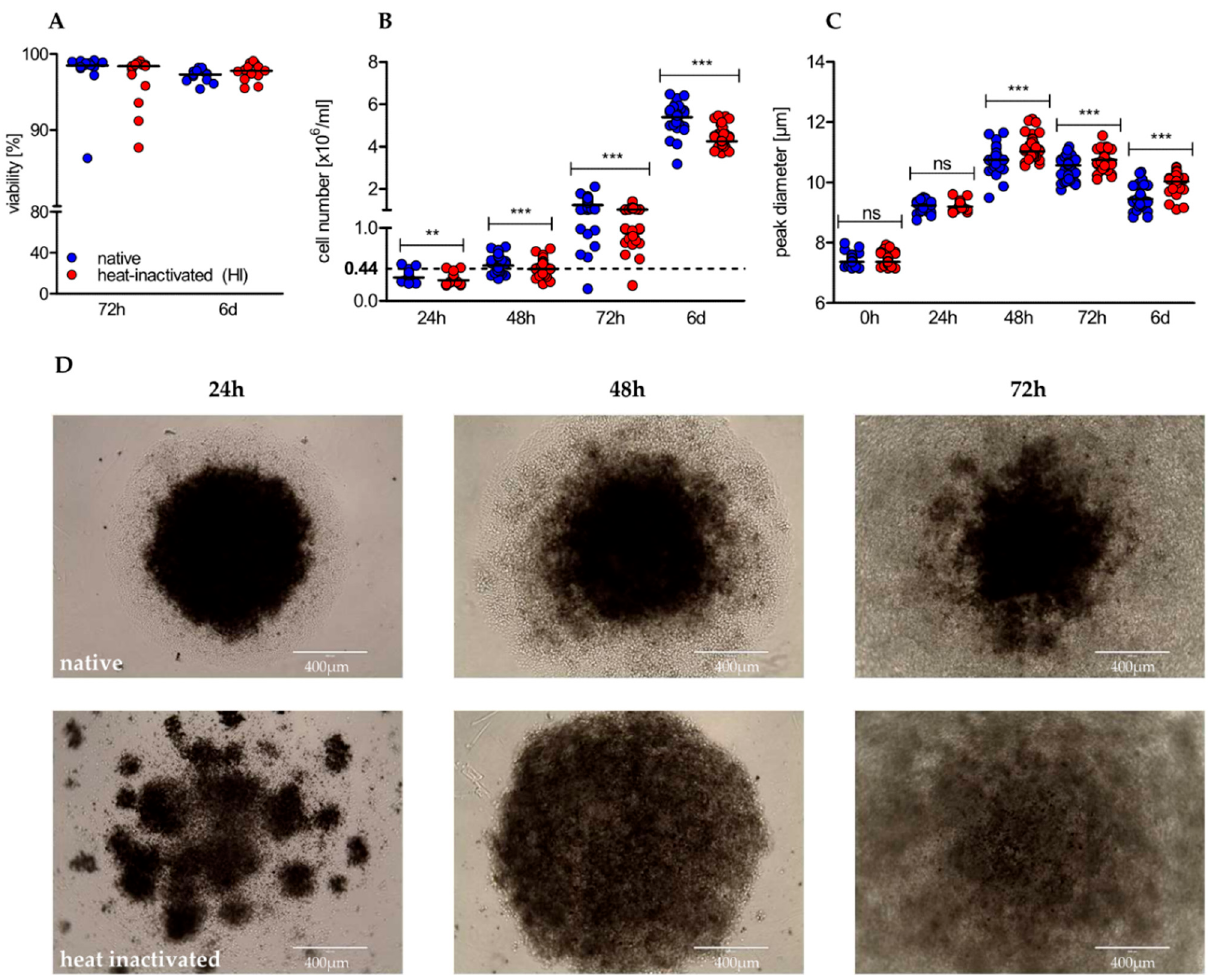
Figure 2. Heat-inactivation of serum barely affects viability, but has significant impact on proliferation, cell growth, and distribution pattern of cultured human CD4+ T cells. ( A ) After 72 h and 6 d of stimulation, viability was determined using the Nicoletti assay by flow cytometry (shown is the median of n = 13 individuals; Wilcoxon test); ( B ) proliferation (shown is the median of 24 h/48 h/72 h/6 d with n = 23/43/48/36; Wilcoxon test; * p < 0.05/4, ** p < 0.01/4, *** p < 0.001/4) and ( C ) cell size were analyzed by the CASY system at indicated time points (shown is the median of 0 h/24 h/48 h/72 h/6 d with n = 43/20/40/45/38; Wilcoxon test; * p < 0.05/5, ** p < 0.01/5, *** p < 0.001/5, ns not significant); ( D ) stimulated CD4+ T cells were optically evaluated at indicated time points using an EVOS cell imaging system at a 10 - fold magnification. One representative donor is shown.